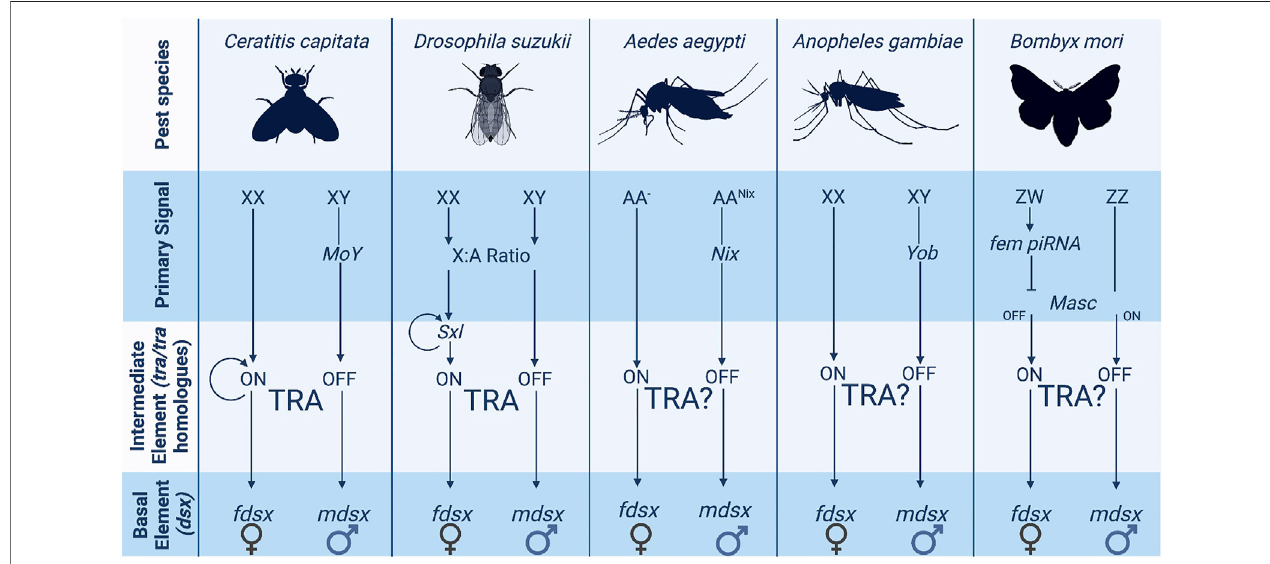
FIGURE 1 | The variety of sex determination systems employed by pest insects. The more upstream elements of the sex determination pathway such as the primary signal vary widely across pest insect species. Several species have XX/XY chromosome structures although they do not utilise them in the same way. Ceratitis and Aedes employ masculinizing elements carried on the Y chromosome whereas Drosophila uses X counting to determine sex.